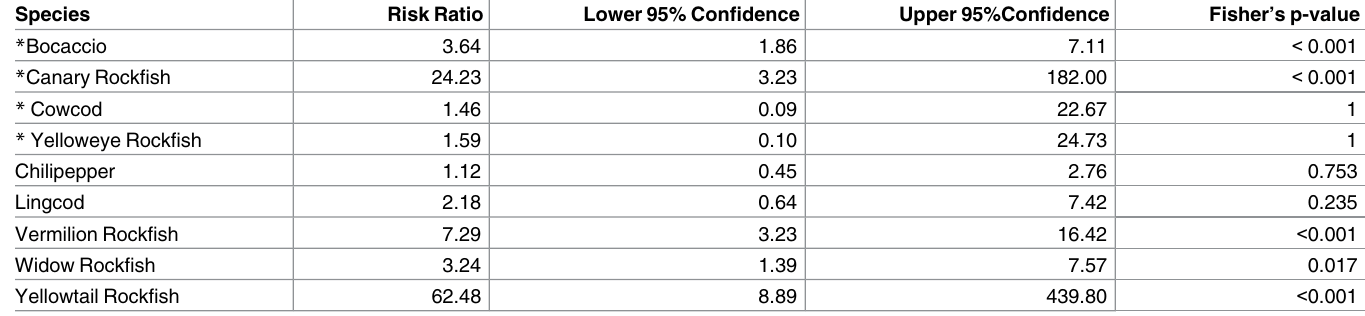
Table 7. Risk Ratios of catching a particular species, given that the species was observed in the same area by video lander. Species